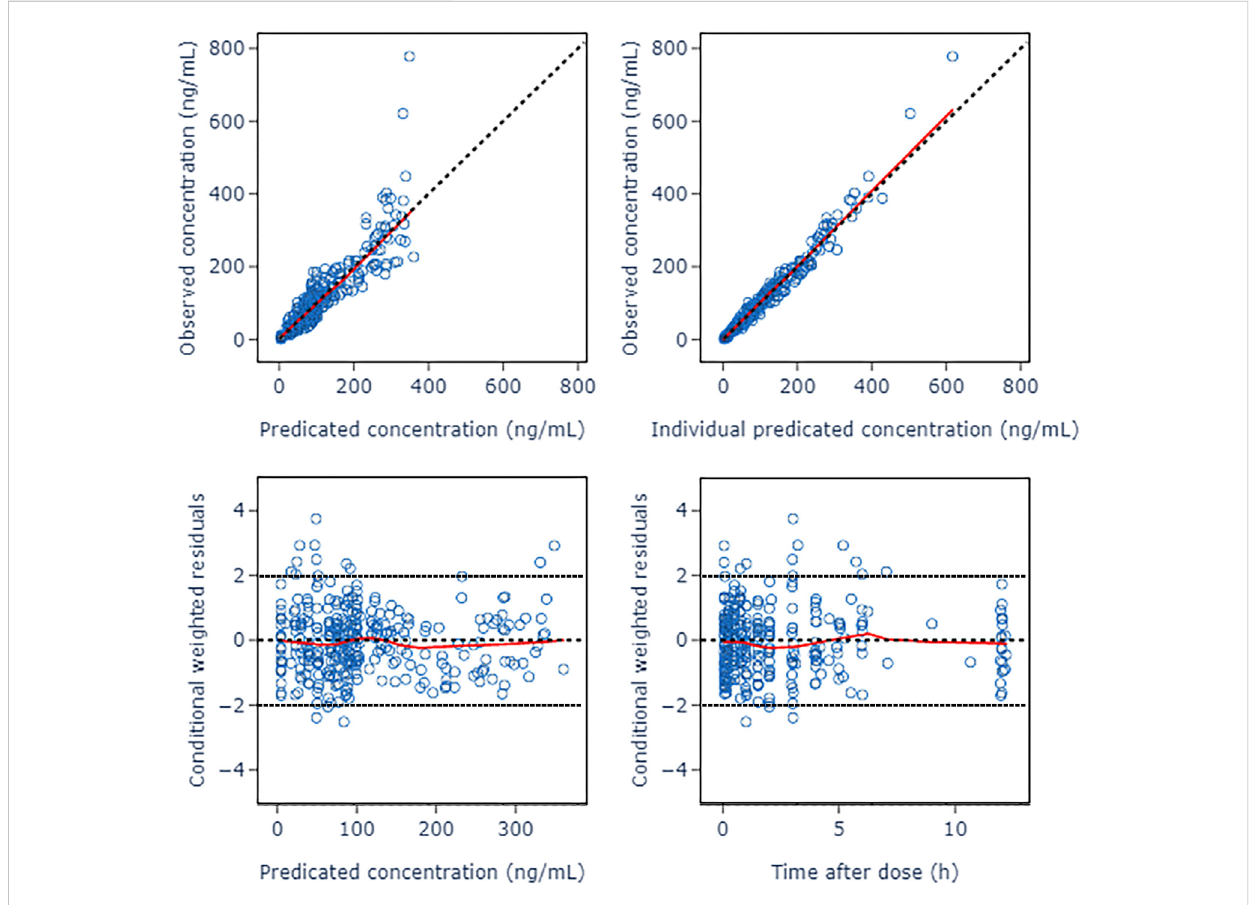
FIGURE 4 Goodness of fi t plots of nalbuphine fi nal PopPK model. The red lines represent the locally weighted scatterplot with